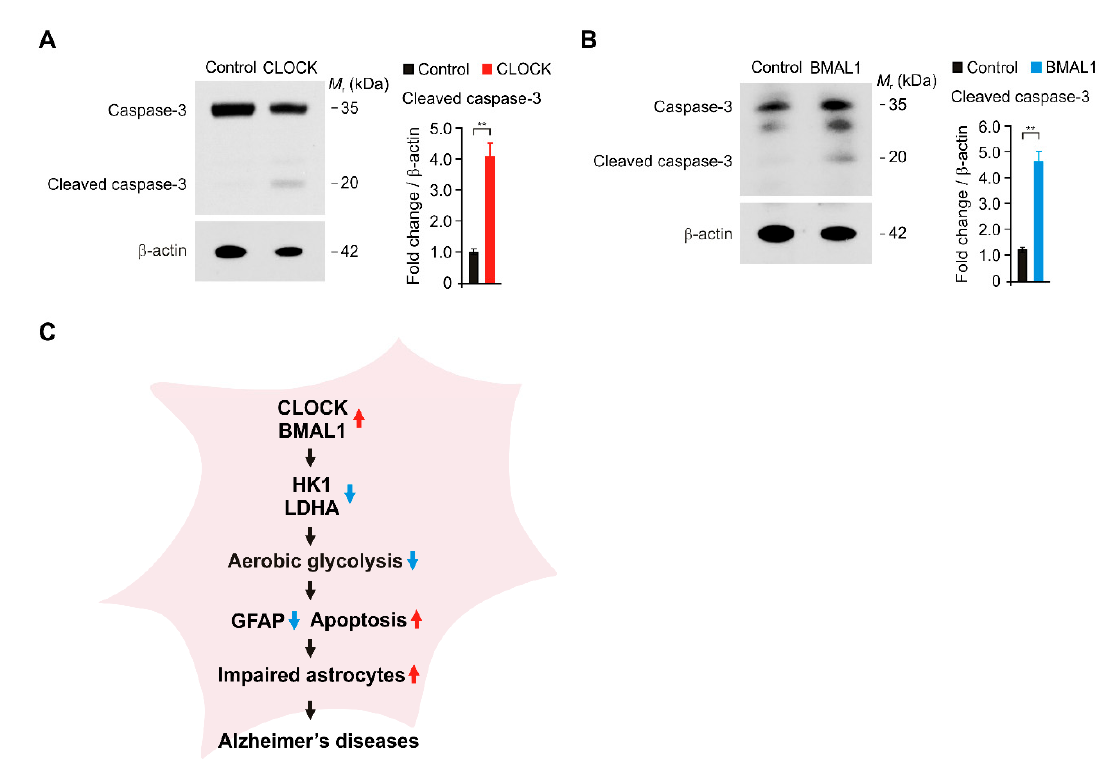
Figure 5. The elevation of CLOCK and BMAL1 induces caspase-3-dependent apoptosis in human astrocytes. ( A ) Representative immunoblot analysis for cleaved caspase-3 and total caspase-3 (left) and quantification for cleaved caspase-3 protein levels (right) in control and CLOCK-overexpressing (CLOCK) human astrocytes. For immunoblots, β -actin was used as loading control. Data are representative of three independent experiments. Data are mean ± SEM. ** p < 0.01 using the two-tailed Student’s t -test. ( B ) Representative immunoblot analysis for cleaved caspase-3 and total caspase-3 (left) and quantification for cleaved caspase-3 protein levels (right) in control and BMAL1-overexpressing (BMAL1) human astrocytes. For immunoblots, β -actin was used as loading control. Data are representative of three independent experiments. Data are mean ± SEM. ** p < 0.01 using the two-tailed Student’s t -test. ( C ) A schematic diagram to summarize our new findings. Red arrow means the increase. Blue arrow means the decrease in a